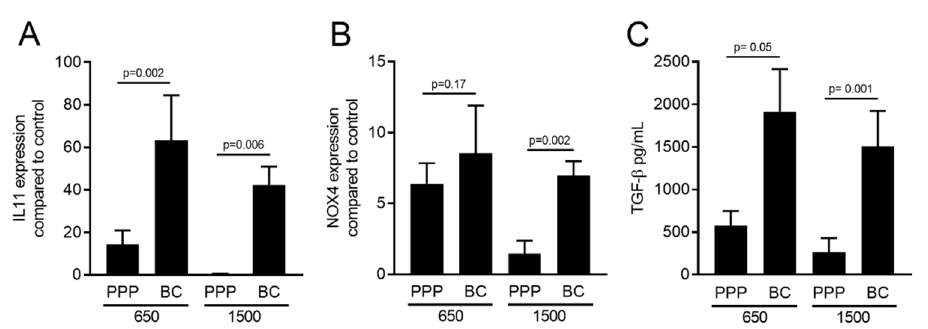
Figure 6. The bu ff y coat (BC) fraction has significantly more TGF- β activity compared to platelet-poor plasma (PPP) in PRF 1500 g and 650 g . Gingival fibroblasts were exposed to 30% of lysates from PPP and BC layers of PRF prepared at 650 g and 1500 g . Analysis of gene expression changes revealed that IL11 ( A ) was upregulated significantly in the BC layer of PRF prepared at 1500 g and 650 g , and the NOX4 ( B ) gene was upregulated in the presence of all variants of PRF lysates. Statistical analysis showed no significant di ff erences ( p > 0.05) between the PPP and BC layers in NOX4 gene expression. These observations suggest that the BC layer has more TGF- β activity compared to the uppermost PPP layer ( n = 6). Concentration of active TGF- β in the BC and PPP fractions of PRF prepared at 1500 g and 650 g was evaluated by immunoassay ( C ). Data represent the mean and standard deviation. TGF- β is indicated in pg/mL. Statistical analysis was conducted using ANOVA ( n = 6).